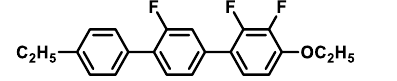
Scheme 5. The trifluoro-substituted terphenyl structure.